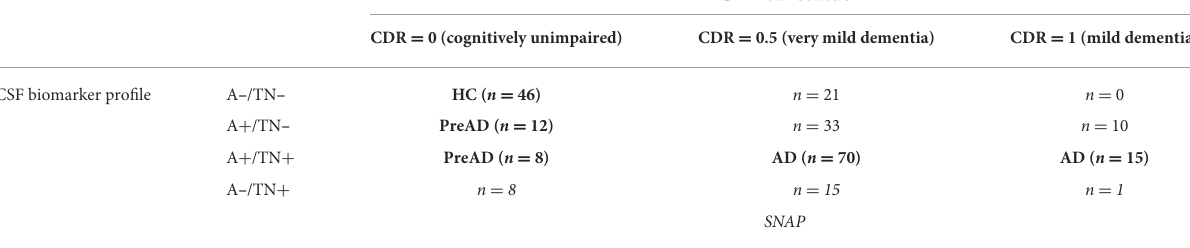
TABLE 1 The classification of the ADNI participants based on the combination of A/T/N mode and clinical status. Clinical status CDR = 0 (cognitively unimpaired) CDR = 0.5 (very mild dementia) CDR = 1 (mild